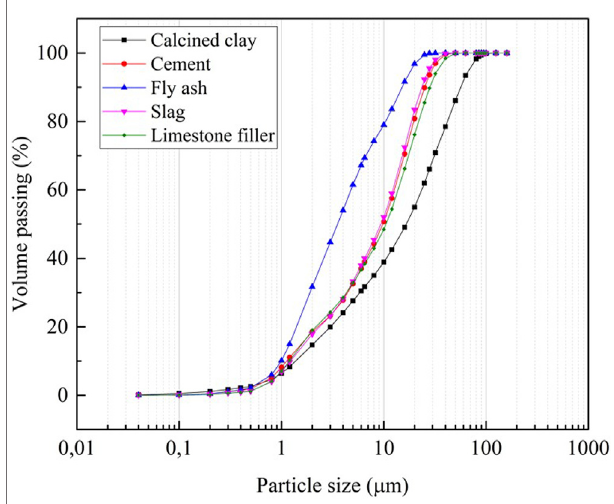
FIGURE 1 | Particle size distribution of cement and SCMs.